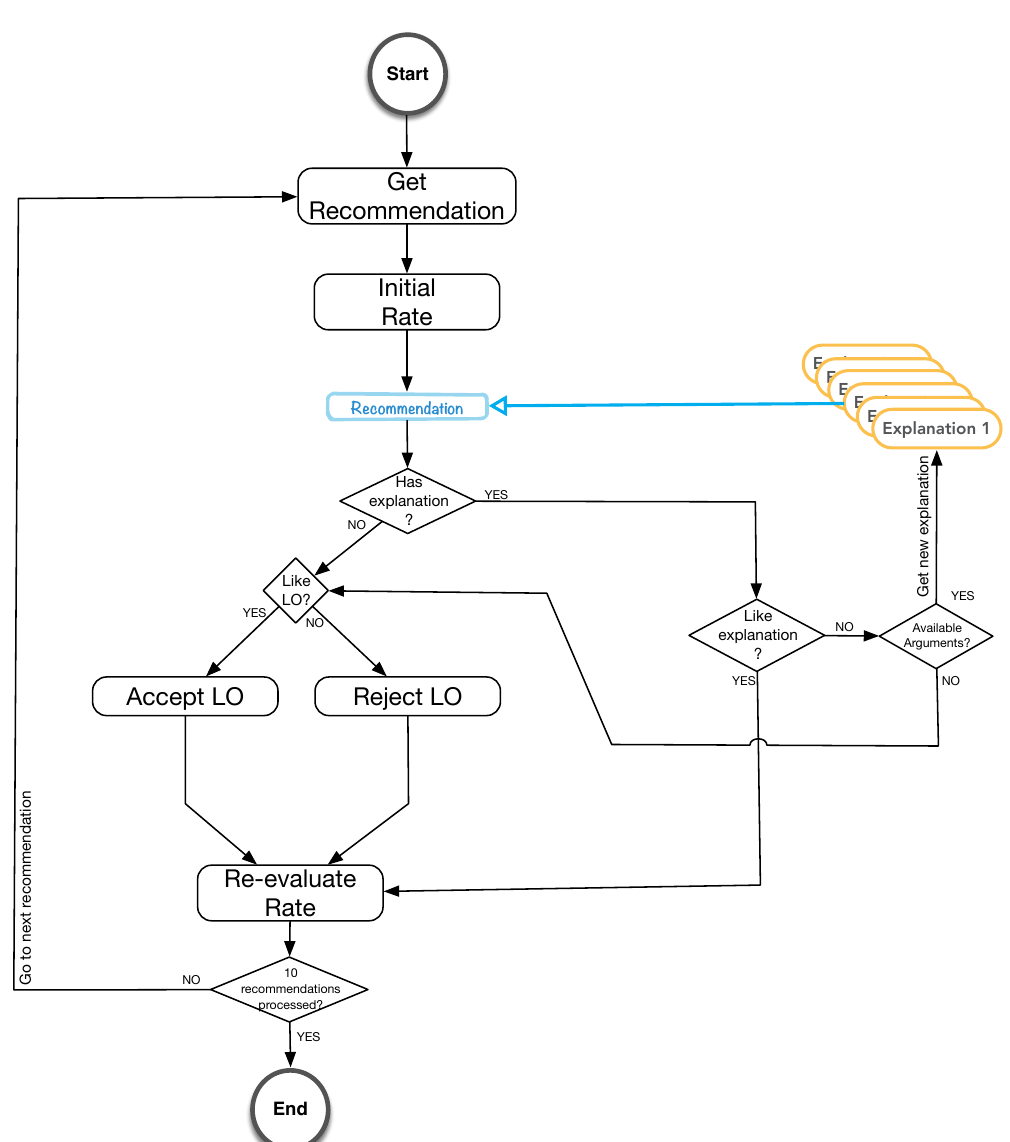
Figure 2. Schema followed by the described experiment.